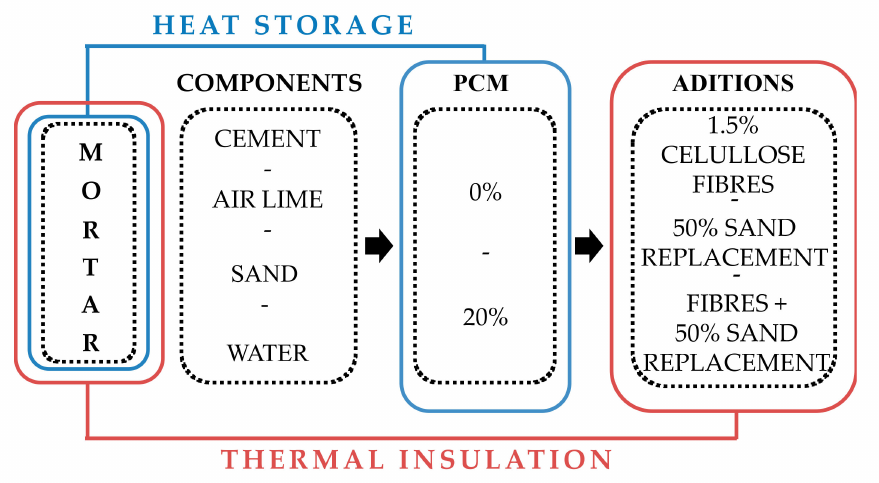
Figure 1. Composition design scheme of PCM cement-lime